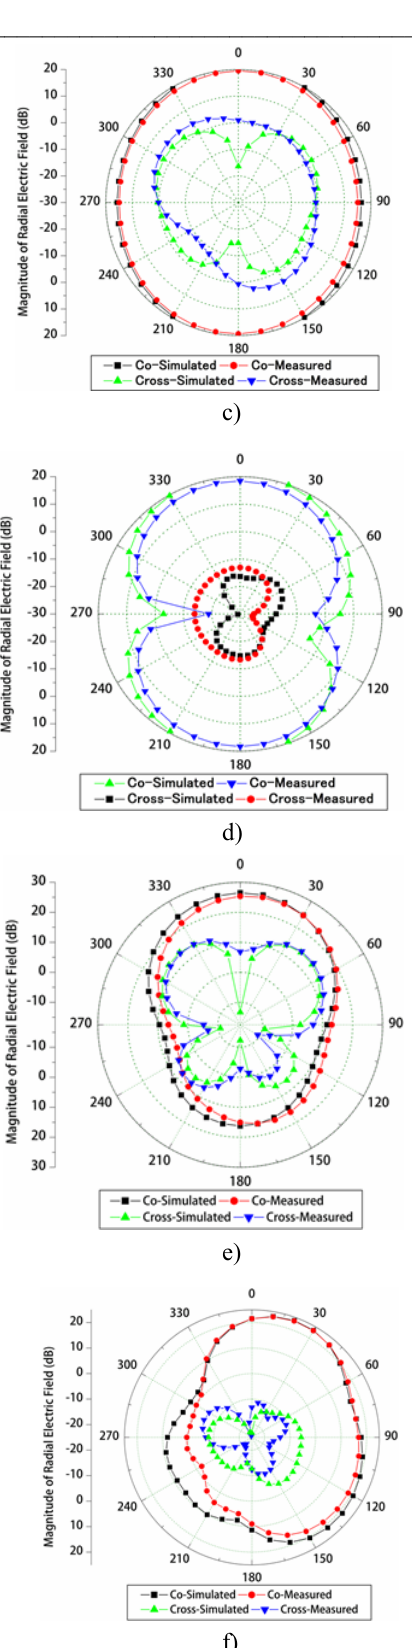
Fig. 7. Simulated and measured E-plane and H-plane co & cross-polarization level at a) 5.7 GHz-E-plane; b) 5.7 GHz-H-plane; c) 8.2 GHz-E-plane; d) 8.2 GHz-H-plane; e) 11.2 GHz-E-plane; f) 11.2